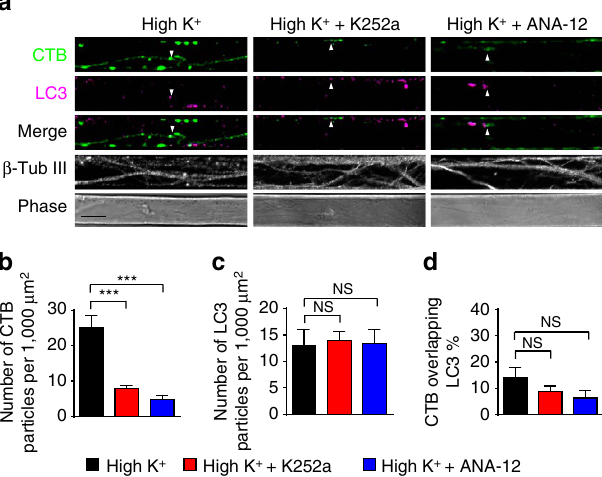
Figure 7 | Pharmacological inhibition of TrkB activation has no effect on LC3-positive autophagosomes. ( a ) Representative images of axons in microfluidic chambers labelled with CTB under high K þ or pretreated with ANA-12, K252a for 30min. TrkB antibody was used to label endogenous TrkB receptors, and co-localization is indicated with arrowheads. Scale bar, 10 m m. ( b – d ) Both inhibitors significantly reduced the number of CTB carriers ( b ) but had no significant effect on the level of the autophagosome marker LC3 in the same region of interest ( c ). The ratio of CTB overlapping with LC3 was also not affected ( d ). (Mander’s coefficient, mean ± s.e.m., n ¼ 39 (high K þ ), 39 (high K þ þ ANA-12) and 38 (high K þ þ K252a) channels, data from two independent neuron preparations, *** P o 0.001, NS, no significant difference; Student’s t -test). the activity-dependent increase in CTB retrograde flux (Fig. 9b,c). Consistent with this, TrkB activation, as determined by high K þ -induced TrkB phosphorylation, was also not affected by these BDNF collators (Fig. 9d,e; full scans in Supplementary Fig. 3d). This confirms our previous results, which demonstrated that the addition of BDNF had no effect on CTB retrograde flux (Supplementary Fig. 1d,e). Taken together, these results indicate that the activity-dependent increase in CTB retrograde flux is independent of BDNF.